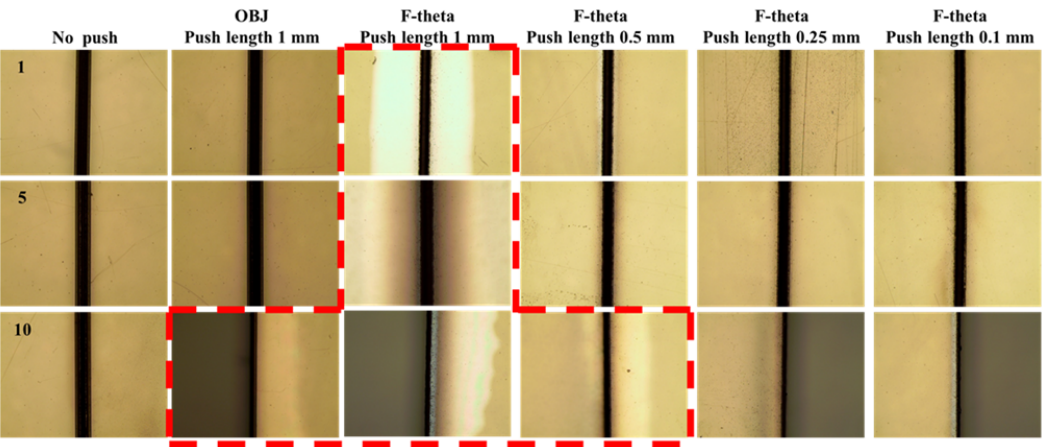
Figure 5. Top surface images of the samples processed by the conventional method and by the new laser ablation method observed with a reflective optical microscope at 10 μ J and 100 mm/s (red dash line: delamination occurrence area).